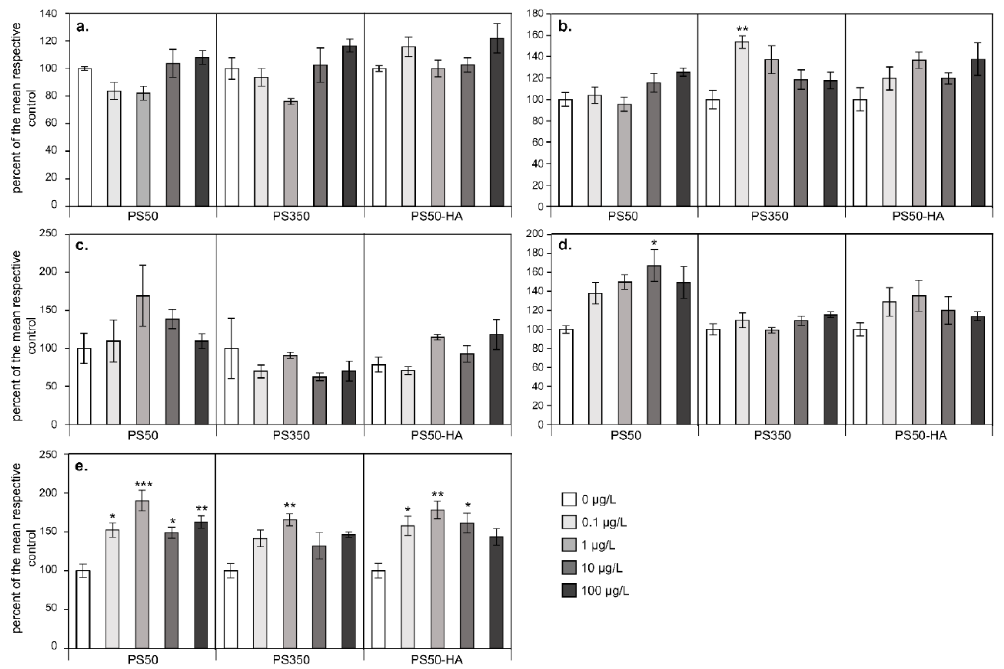
Figure 2. Results of 96 hr growth tests performed with Nitzschia palea ( a ), Gomphonema parvulum ( b ), Nostoc sp. ( c ), Komvophoron sp. ( d ) and Scenedesmus obliquus ( e ) exposed to PS50, PS350 and PS50-HA. The values are expressed as percentages of the respective control. Mean ± SE (n = 4), asterisks correspond to data significantly different from the corresponding control (*: p < 0.05); **: p < 0.01; ***: p < 0.001).